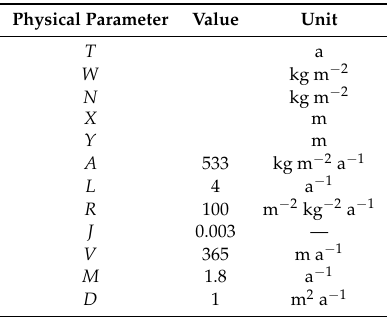
Table A1. Physical parameters and their default values and units are shown for grass. The values are taken from Klausmeier [30].